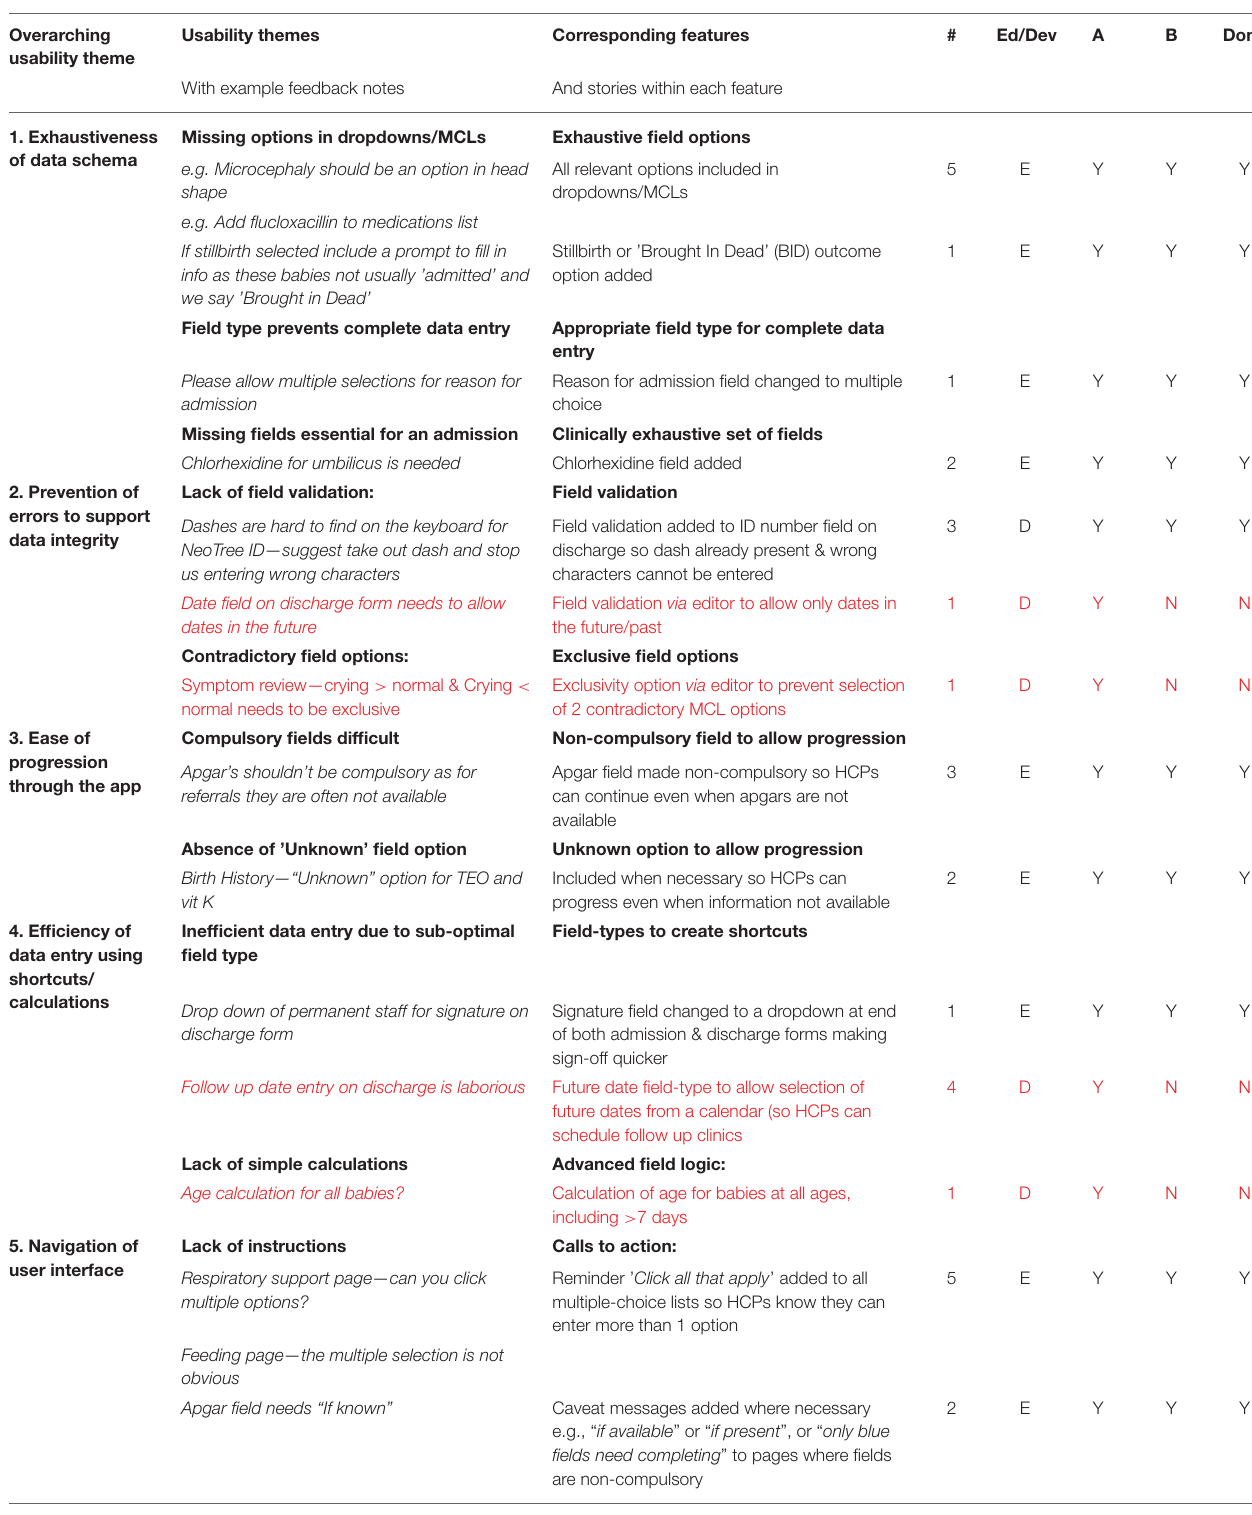
TABLE 4 | Usability as an electronic medical record—Data collection feature set. Overarching usability